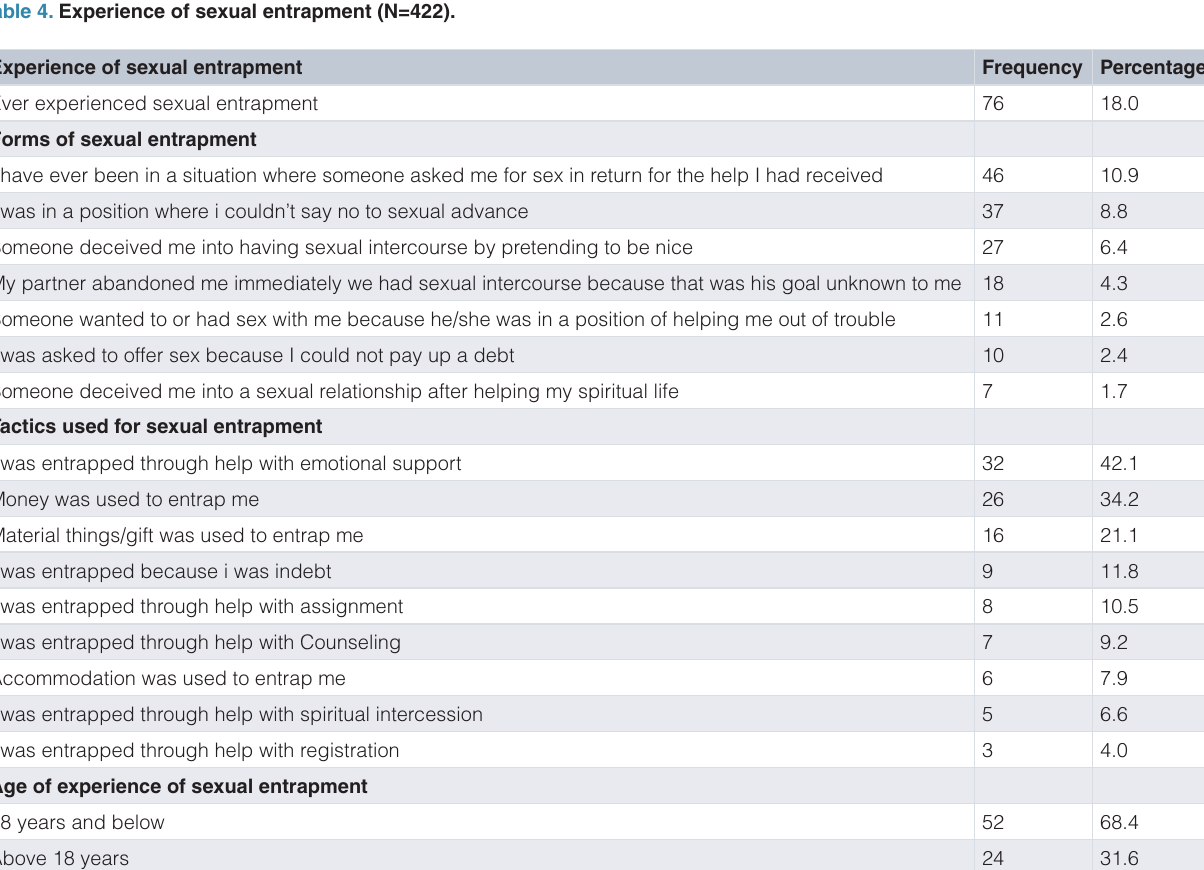
Table 4. Experience of sexual entrapment (N=422).